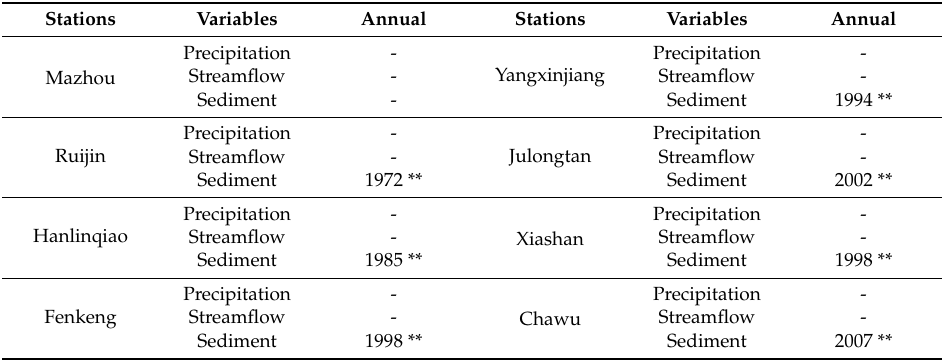
Table 3. The change-point analyses for annual precipitation, streamflow, and sediment